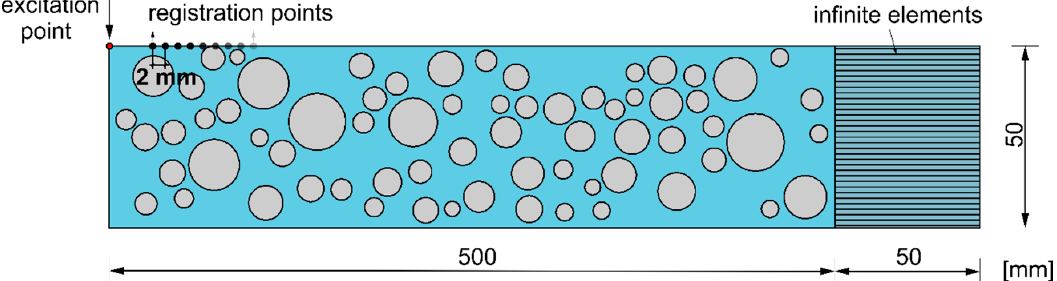
Table 1. Material parameters of matric mortar and aggregate particles.